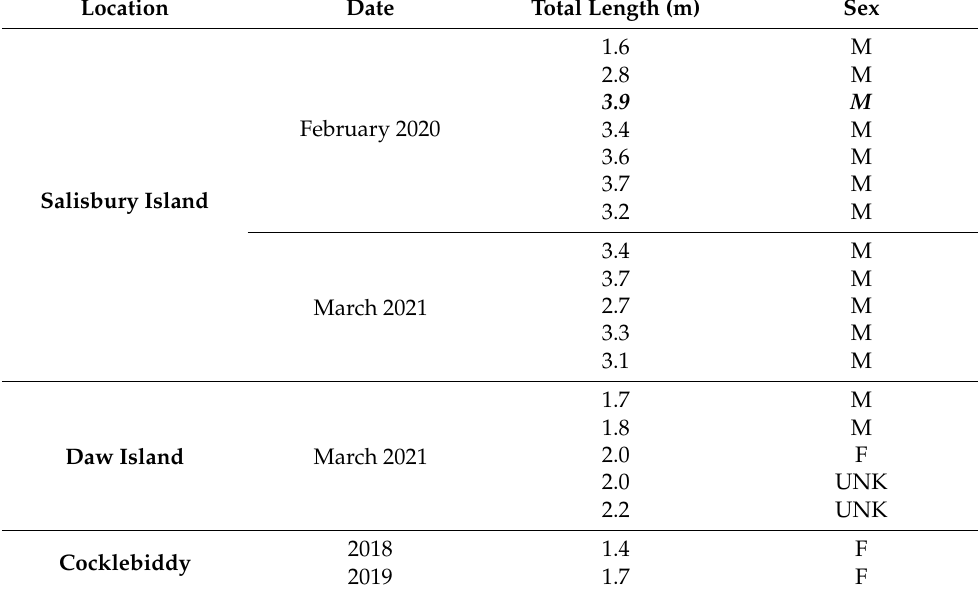
Table 1. Total length (TL) measurements collected from white sharks ( Carcharodon carcharias ) encoun- tered at Daw Island, Salisbury Island, and Cocklebiddy, Western Australia. These TL measurements were collected using laser and stereo-photogrammetry as well as from bycatch associated with the bottom gillnet fishery targeting gummy sharks ( Mustelus antarcticus ). Sex is denoted as male (M), female (F), or unknown (UNK). Mature adult sharks are identified by bold and italicized text (n = 1), whereas young-of-the-year and juvenile sharks are identified by normal text (n = 18). Location Date Total Length (m) Sex